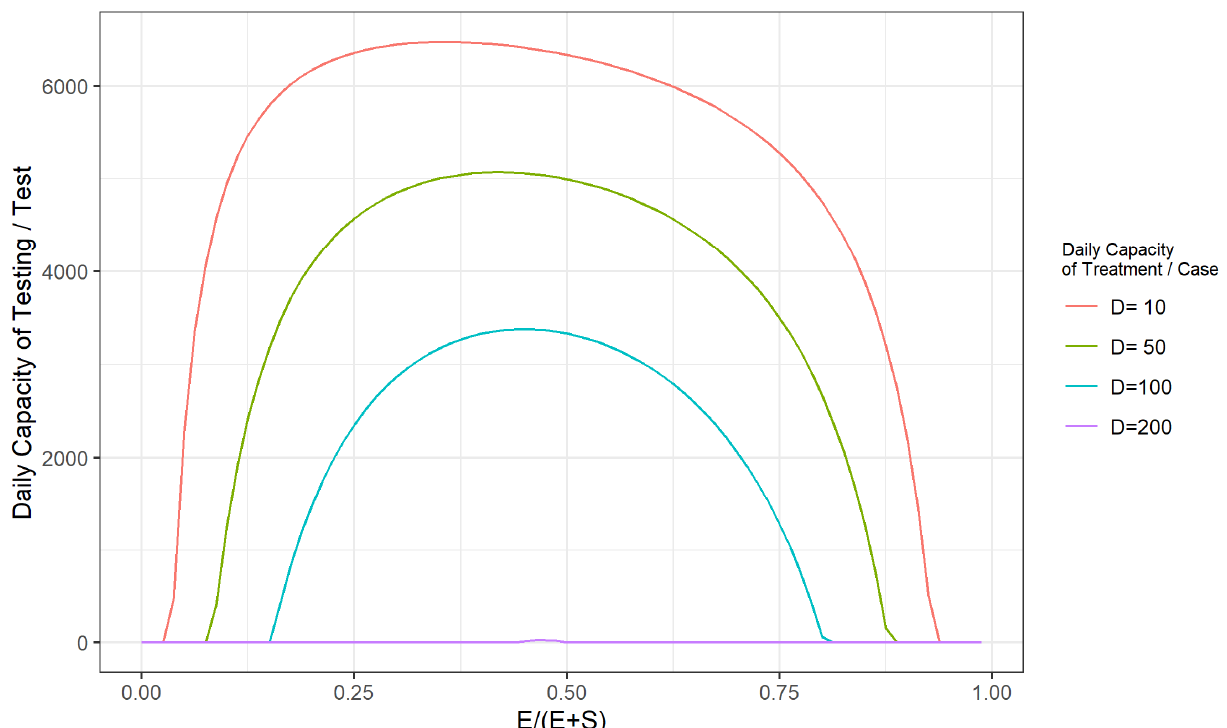
Figure A14. Relationship between the daily testing capacity of the epidemic and the potential level of the epidemic development ( S + E = 9000, I = 1000).